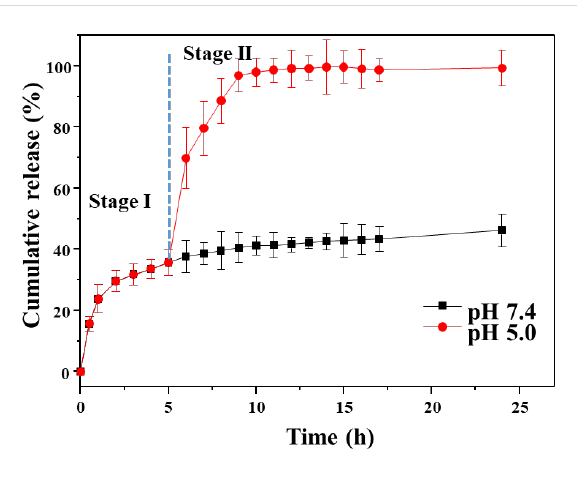
Figure 4: Cumulative release curves of DOX-loaded β -CD-BM 2 based SSAs at pH 7.4 and 5.0, respectively.